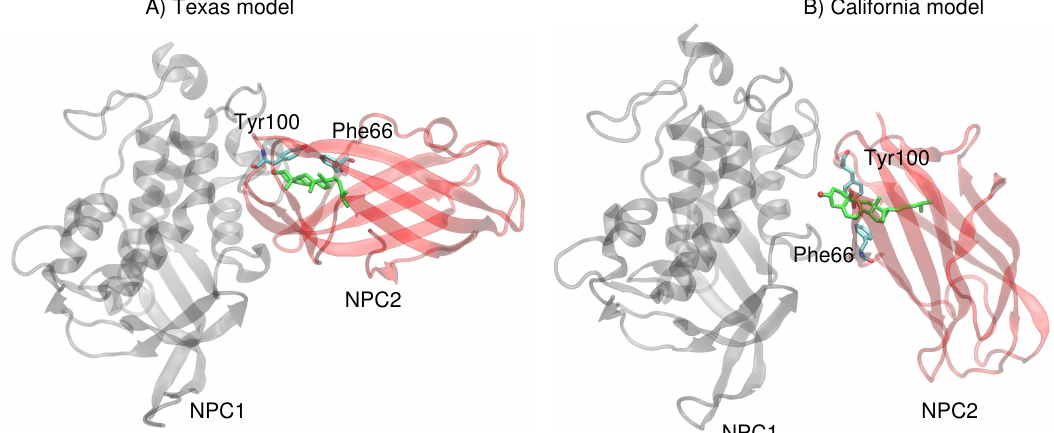
Figure 6. ( A ) In the Texas model, the cholesterol ring system is engaged in π – π interactions with Phe66 and Tyr100 of NPC2. ( B ) In the California model, Phe66 and Tyr100 of NPC2 point downward and away from the cholesterol